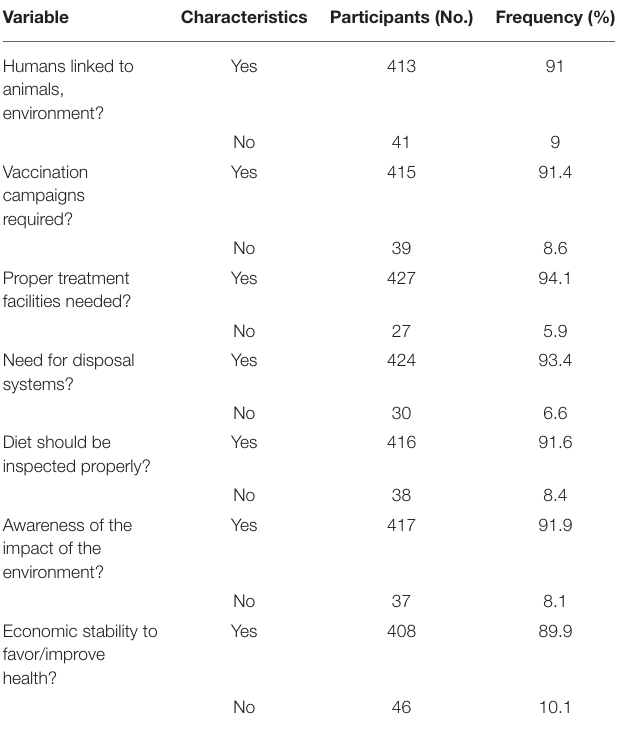
TABLE 3 | Representation of one health concept of CE across different variables.